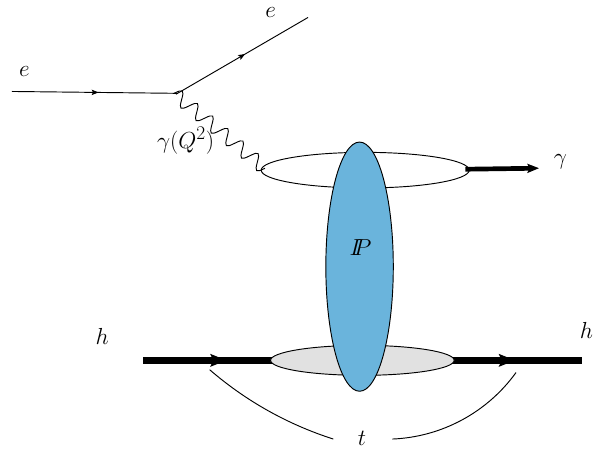
Fig. 1 Deeply virtual Compton scattering in coherent diffractive pro- cesses, where the hadron can be a proton or a